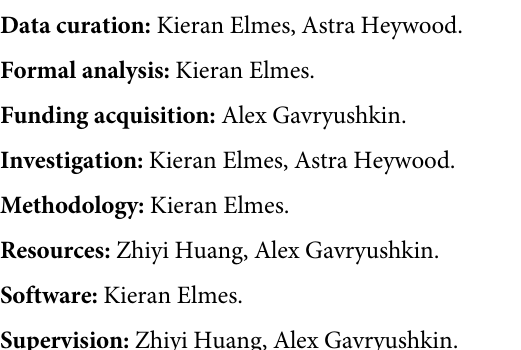
S1 Table. Predicted top 50 SNV effects in the antibiotic data set. (PDF) S1 Fig. Compression effect on memory use. Note that this is the total peak memory use of the program, not solely the memory used by the matrix X (TIF) S2 Fig. Comparison of compression methods. (a) Total memory used, compressing the sparse X matrix with each method. (b) Total time taken and time taken (including compress- 2 ing X ) and time taken for lasso regression alone, using each method. 2